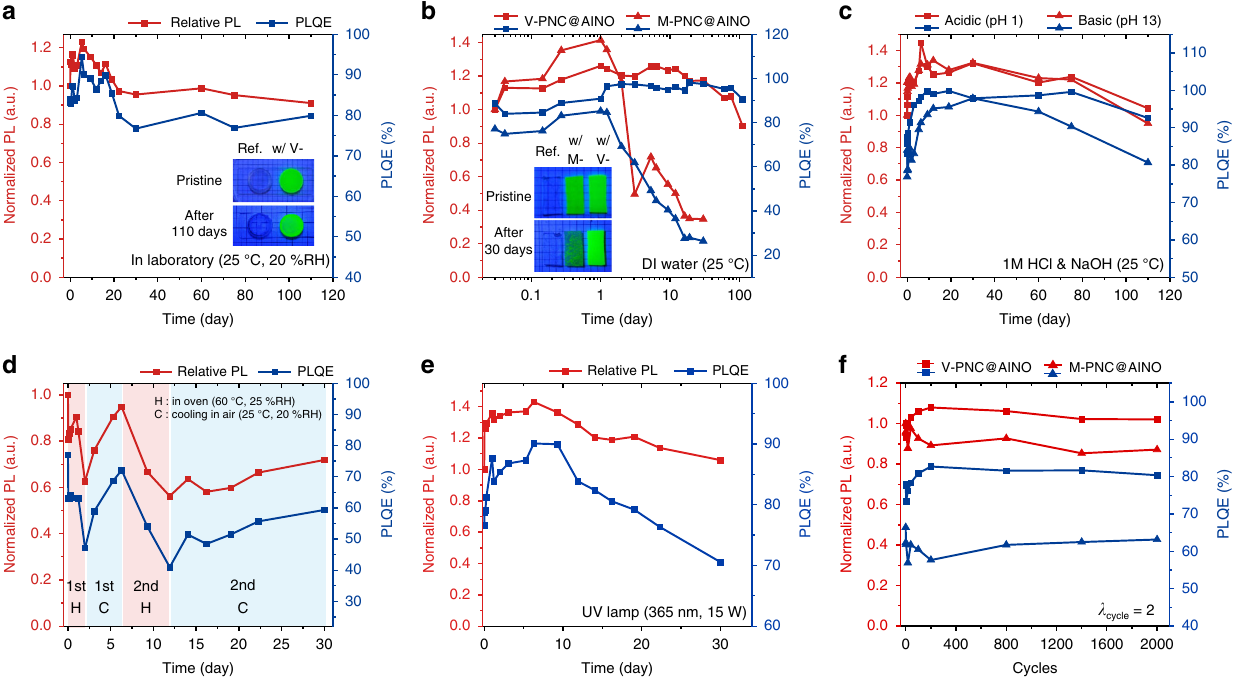
Fig. 4 Environmental stabilities of the PNC@AINOs. a Relative PL intensity and PLQE of the V-PNC@AINO in ambient air. Inset shows the reference AINO and the nanocomposite from initial state to after 110 days under air exposure. RH relative humidity. b Luminescence behavior of the nanocomposites soaked in DI water clearly differs with the type of PNC. Inset shows the reference AINO (left), M-PNC@AINO (middle), and V-PNC@AINO (right) from initial state to after 30 days in water. c The luminescence increasing behavior of the V-PNC@AINO soaked in water is unaffected by its pH. d Heat markedly decreases the PL intensity and PLQE of the V-PNC@AINO, but they recover under ambient air. e Relative PL intensity and PLQE of the V- PNC@AINO under UV irradiation. f Relative PL intensity and PLQE of the nanocomposites during stretch-and-release cycle test. The concentration of the PNC in all nanocomposites for stability tests is 12 mg ml − 1